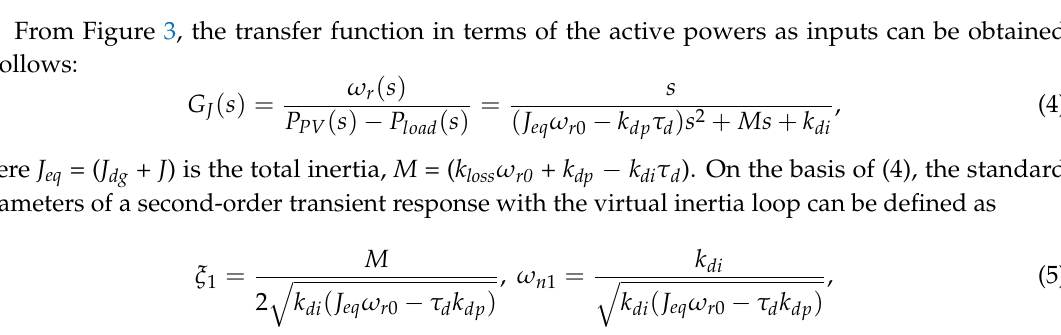
Figure 3. DGS speed control with the virtual inertia control loop.